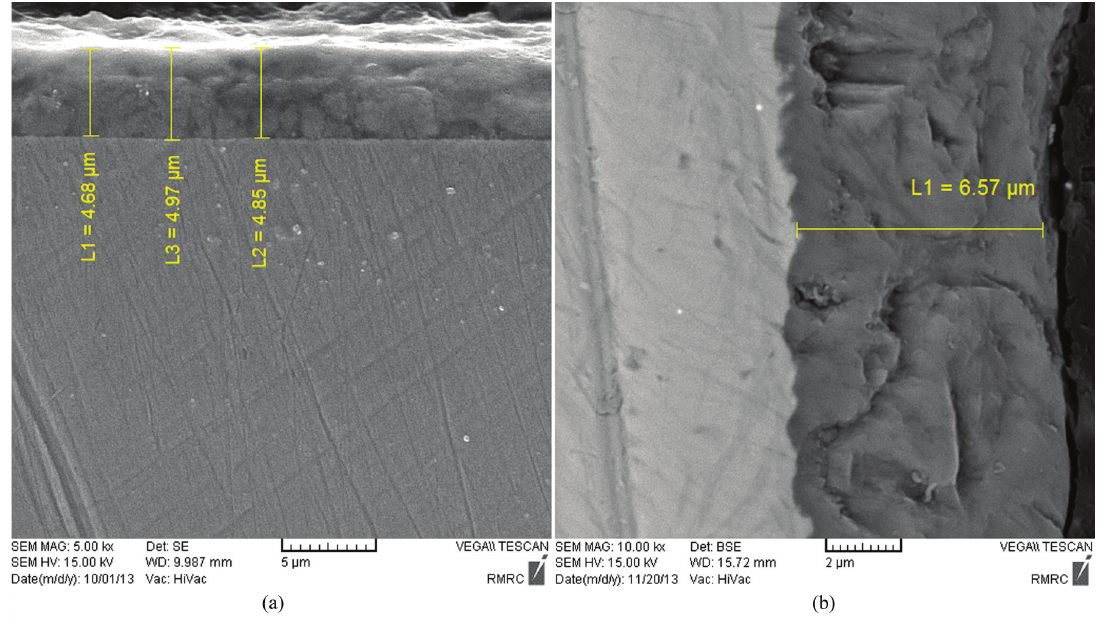
Figure 4. SEM images of deposited TiCN thin films for CH4/ (CH4+N2) gas flow ratio a)66%